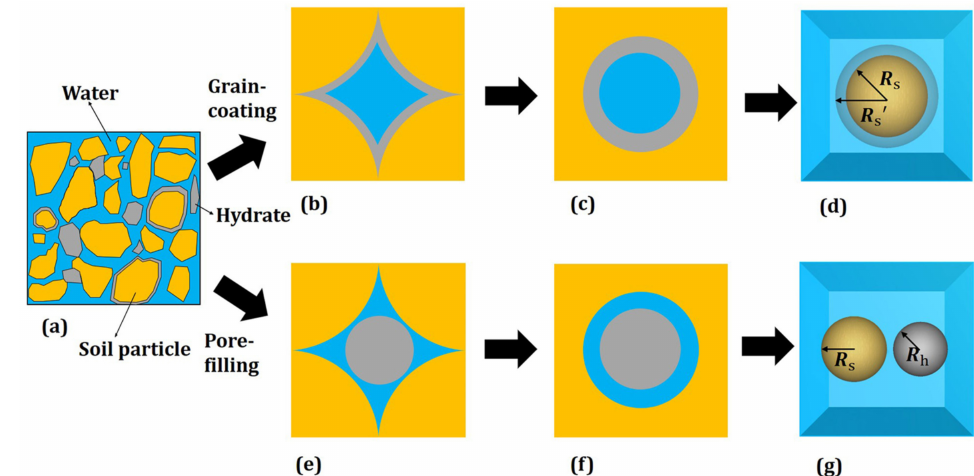
Figure 27. The schematic diagram of saturated sediment with hydrates reprinted from [58] with permission from Elsevier. ( a ) The real internal pore structure of HBSs; ( b ) grain-coating hydrates in HBSs; ( c ) capillary tube with grain-coating hydrates; ( d ) the 3D hydraulic radius of grain-coating hydrate; ( e ) pore-filling hydrates in HBSs; ( f ) capillary tube model with pore-filling hydrates; ( g ) the 3D hydraulic radius of the pore-filling